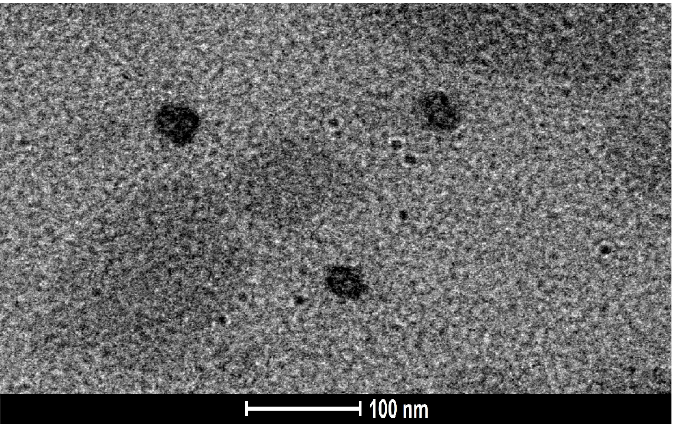
Figure 6. Surface morphology (TEM) image of optimized AZL-NE formulation.